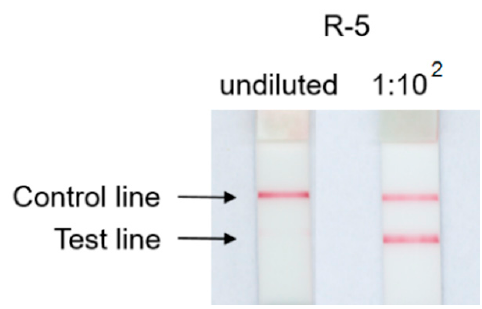
Figure 3. Hook effect observed in LFD1: Retail food R-5 tested negative from an undiluted sample Figure 3. Hook e ff ect observed in LFD1: Retail food R-5 tested negative from an undiluted sample extract, but positive after 1:10 2 extract dilution. extract, but positive after 1:10 2 extract